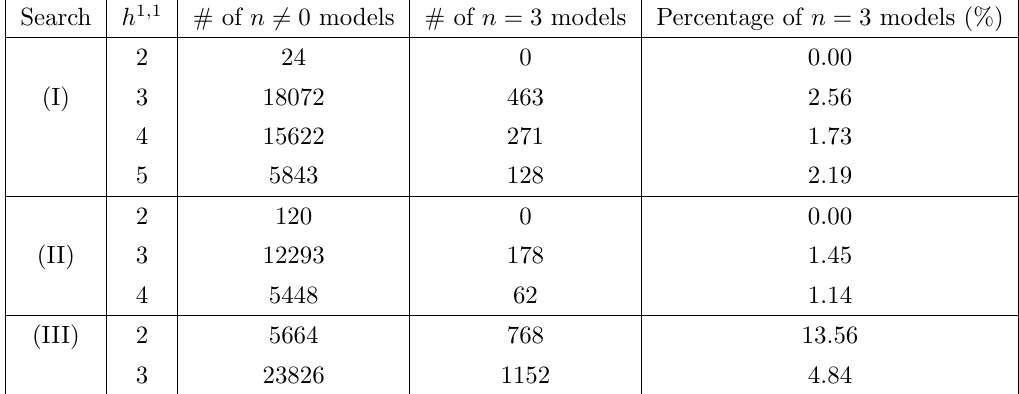
Table 1 . Maximal values of Hodge number h 1 ; 1 (cid:3) and the (cid:13)ux m (cid:3) , K-theory condition and the number of random attacks R 1 ; 2 for each search. max